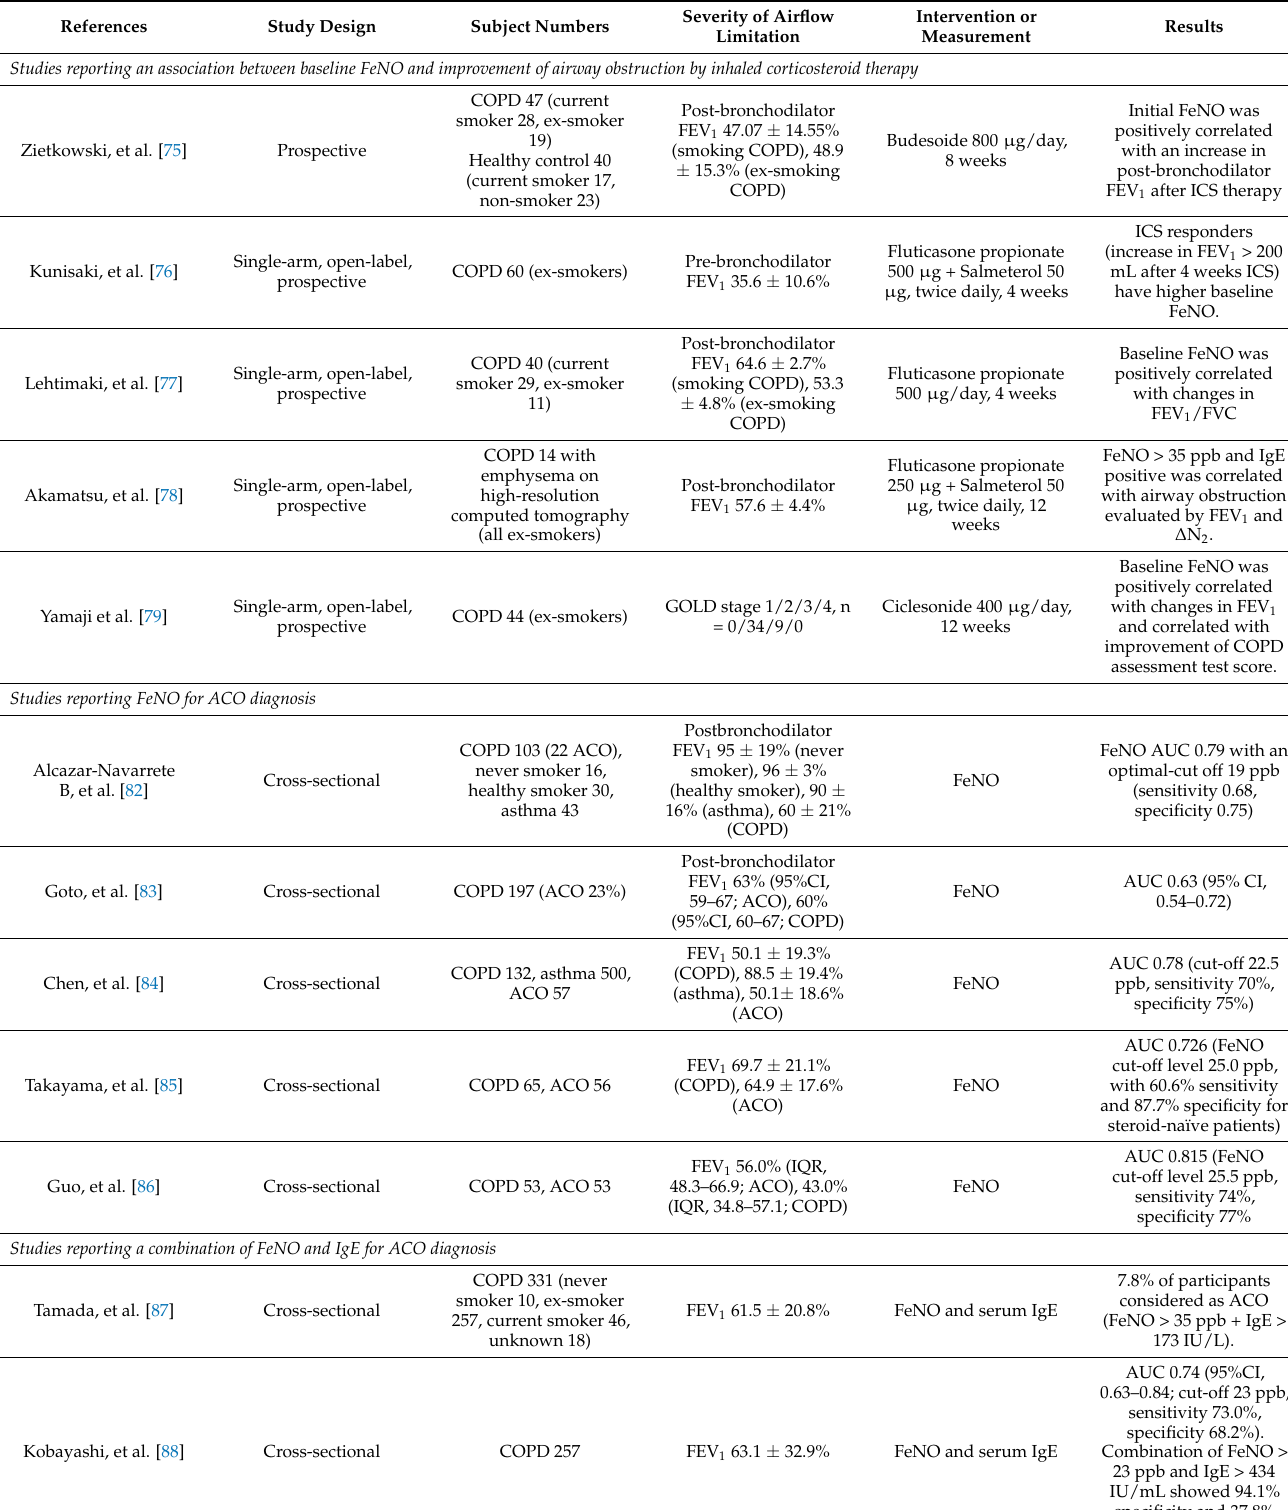
Table 1. Characteristics of included